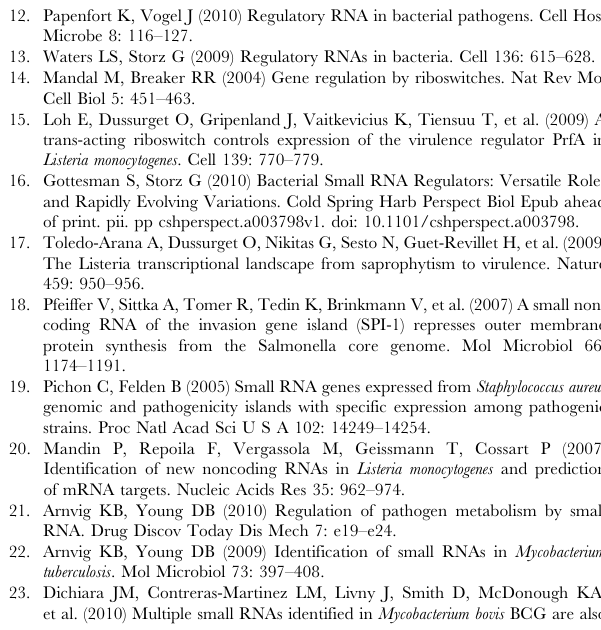
Figure S4 Mapping of sRNA transcriptional start sites and predicted transcription factor binding sites. Panel A shows the region surrounding MTS0977. The 5’ end (not TAP specific) was mapped to the G nucleotide shown by an asterisk. Putative promoter elements as well as CRP binding site (CBS) are outlined by rectangles. The 3’ end is approximate, based on the size of the transcript (as judged by Northern blotting) and structural predictions (using Mfold). The start of Rv1265 was mapped to the 2 35 element of MTS0997.Panel B shows RLM- RACE result for mapping the transcription start sites of MTS1338 (using primer 1338.R, and indicated by asterisks above the sequence) and the region surrounding MTS1338 with DosR binding sites according to [46] indicated. Figure S5 Distribution of down-regulated genes upon over-expression of MTS2823. Genes involved in energy metabolism (class I.B) are over-represented among down-regulated genes. Genes identified as down-regulated $ 2.5-fold by micro- array analysis were grouped according to the functional class of their predicted gene product as assigned in the original genome annotation [10]. Values on the x-axis represents a difference in percentage, positive values indicate over-representation of a particular functional class whereas negative values indicate under-representation. Asterisks indicate P 2 value , 0.01 after FDR correction. Figure S6 Effect of MTS2823 over-expression on M. tuberculosis genes. The figure shows a Volcano plot of the microarray data, which illustrates how the majority of genes are down-regulated as a result of MTS2823 over-expression.